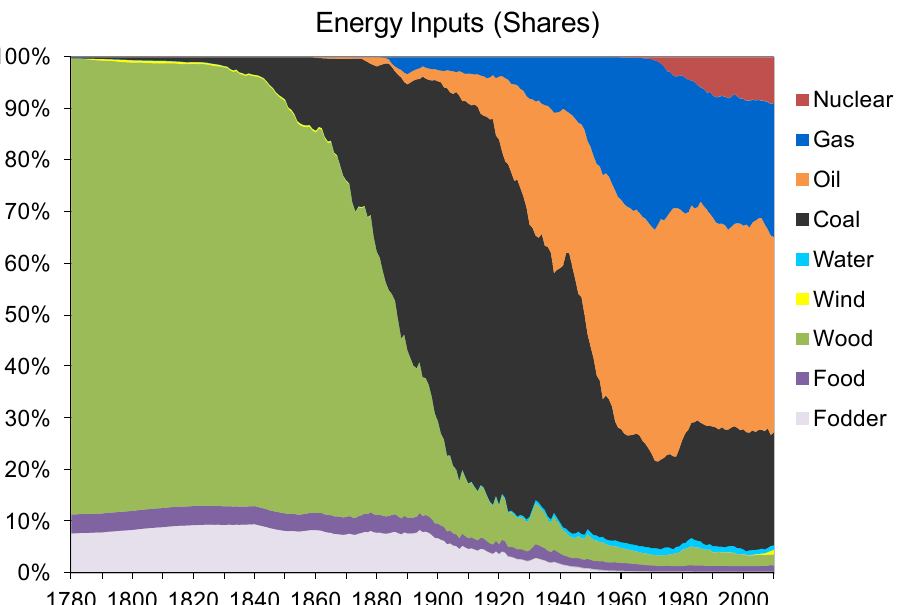
Figure 15. Shares of inputs to U.S. energy consumption, 1780–2010. Sources: various; see individual energy series in Section